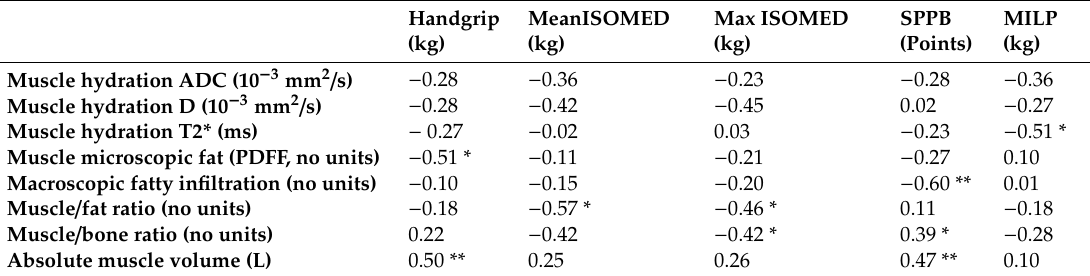
Table 4. Statistically significant correlations between imaging biomarkers and functional parameters with | r | > 0.4.